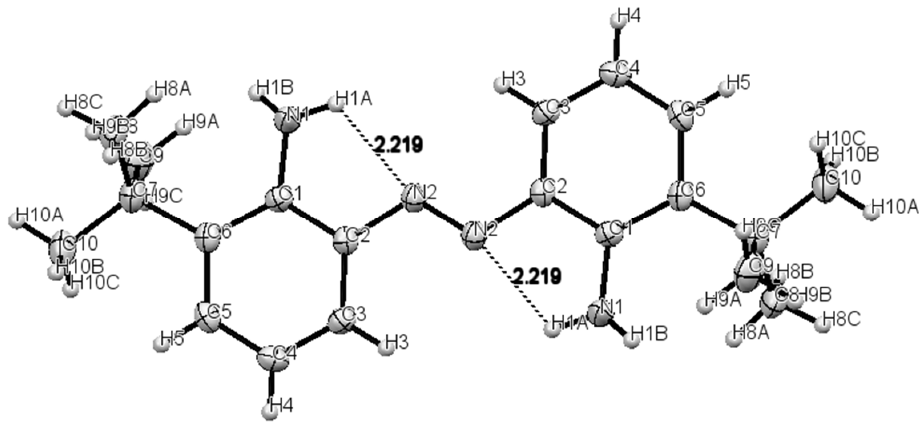
Figure 3 . The NH ⋯ N=N hydrogen bonds in C as revealed by X-ray diffraction studies (CCDC 1828796).